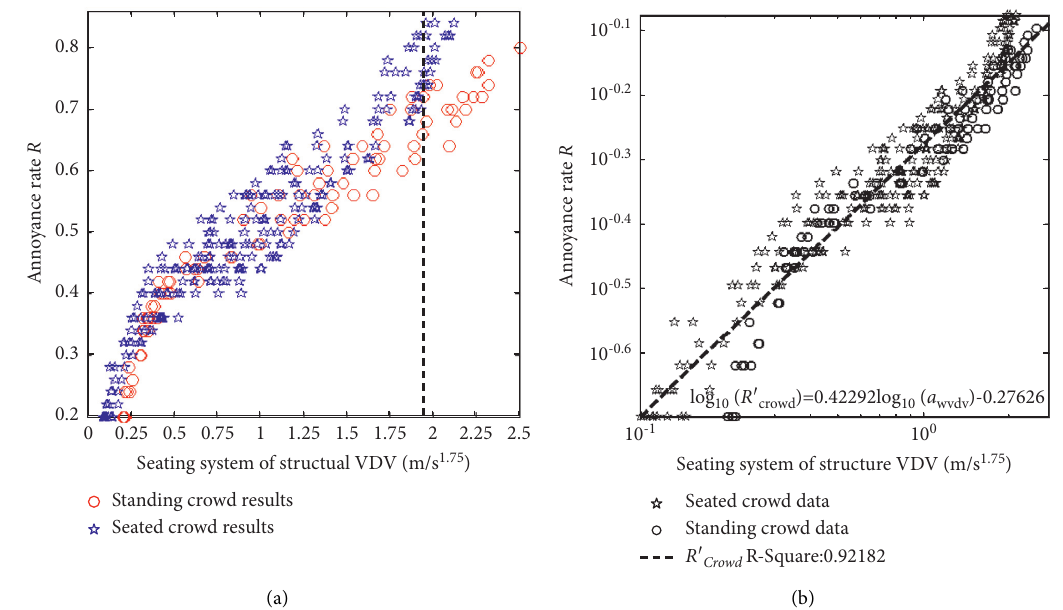
Figure 9: The distribution of crowds annoyance rate according to shaking table tests at logarithmic coordinate. (a) Cartesian coordinate system; (b) logarithmic coordinate